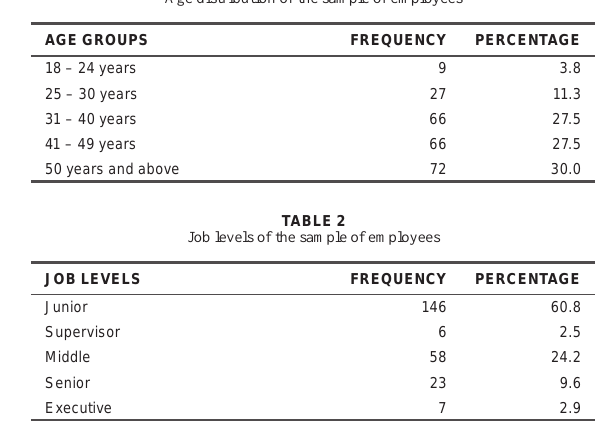
TABLE 1 Age distribution of the sample of employees